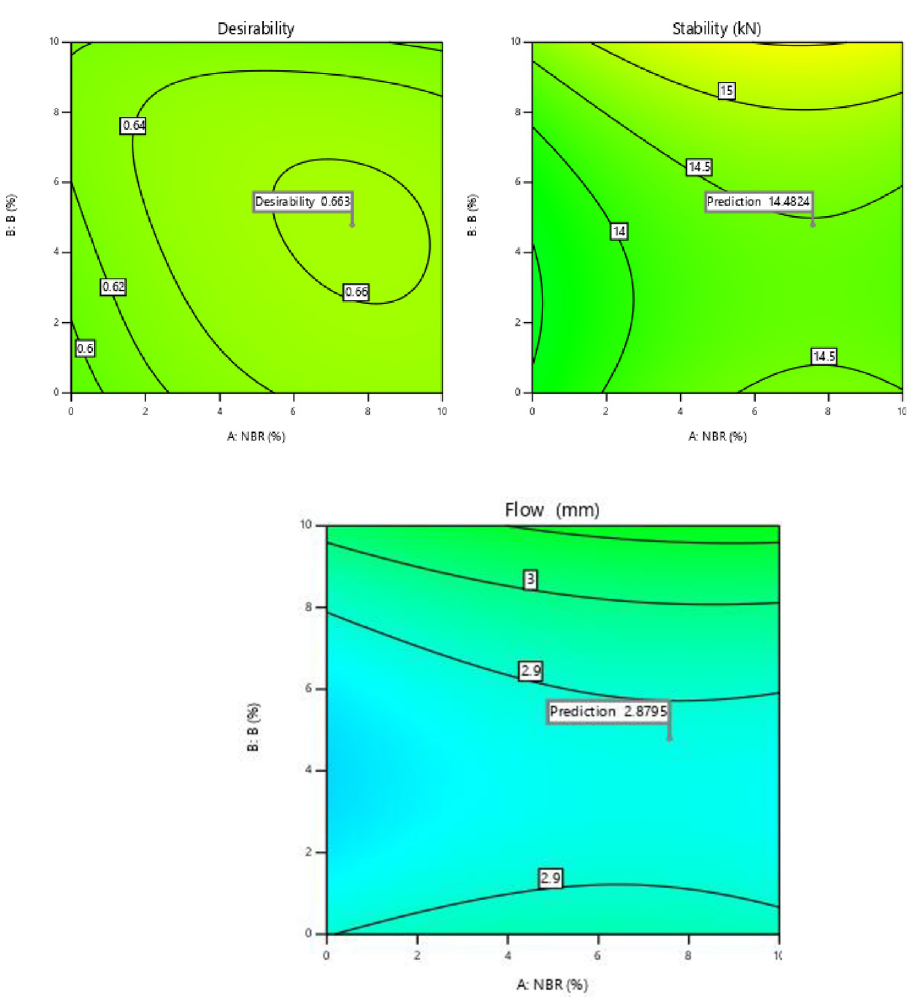
Fig 8. Composite desirability of MS and